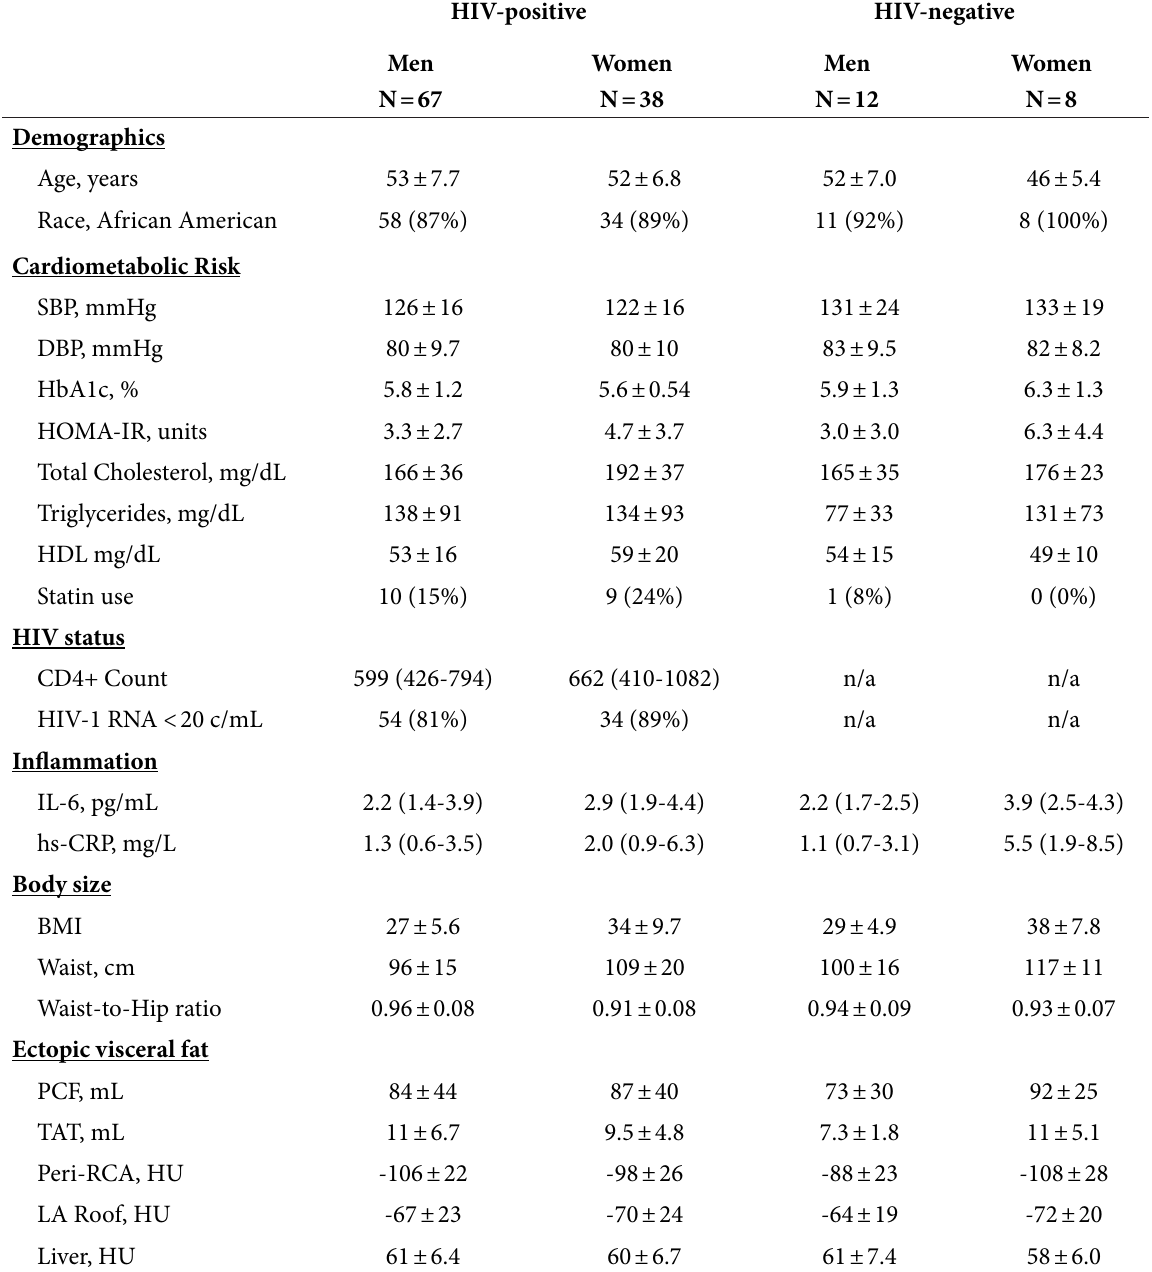
Table 1. Participant Characteristics Stratified by HIV Status and Sex